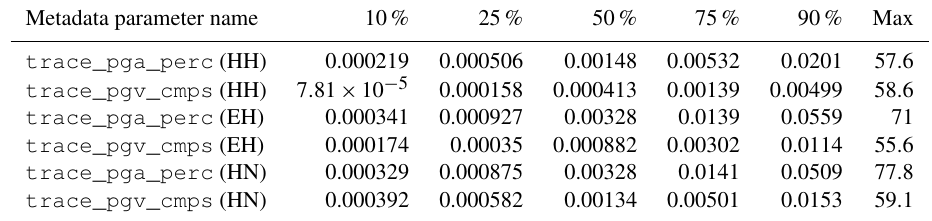
Table 4. Distribution according to different quantiles of IM selected metadata for the HH, EH, and HN channels. Metadata parameter